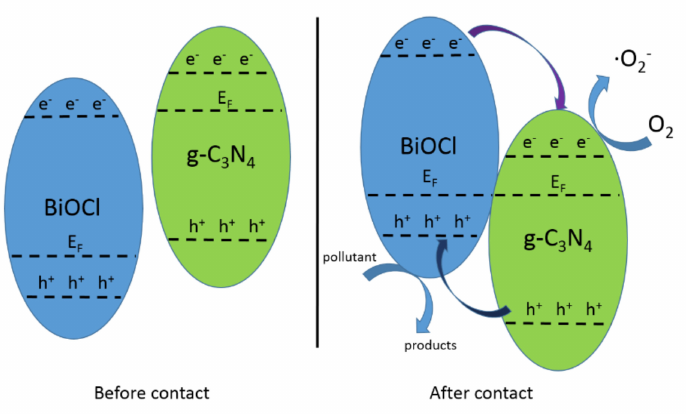
Figure 7. The schematic mechanism of g-C 3 N 4 /BiOCl p-n junction. Hybrid density-functional theory (DFT) calculation was used to anticipate the proper- ties of the g-C 3 N 4 /BiOCl composite [51]. G-C 3 N 4 and BiOCl could form a stable composite with a narrower bandgap (2.1 eV), then the absorption of visible light was